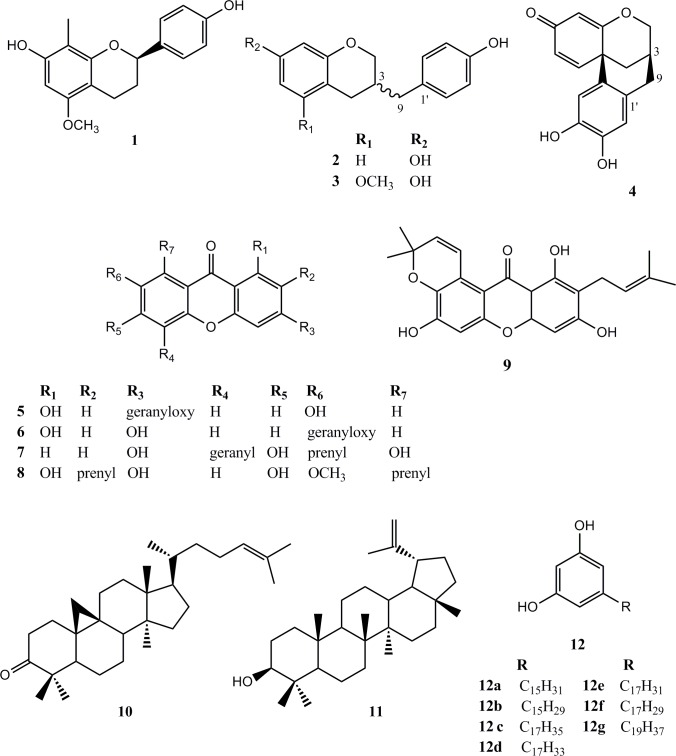
Chemical structures of isolated compounds.